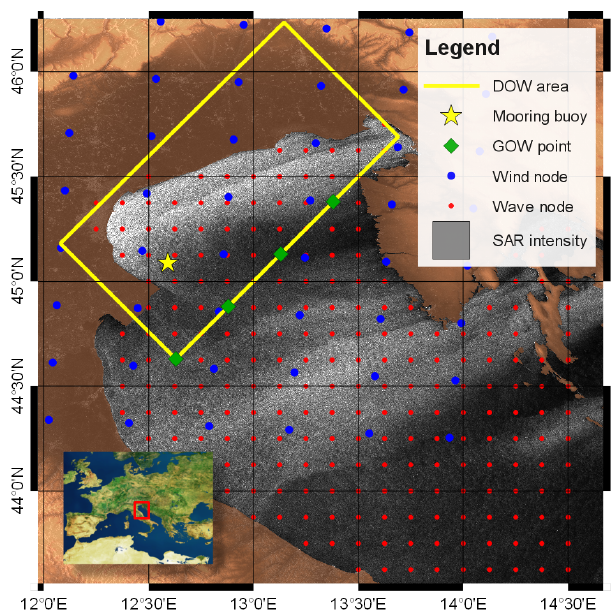
Figure 1. Modeled domain in the northern Adriatic Sea basin. Background shows σ 0 of the ENVISAT ASAR WS image acquired on 2 February 2012,